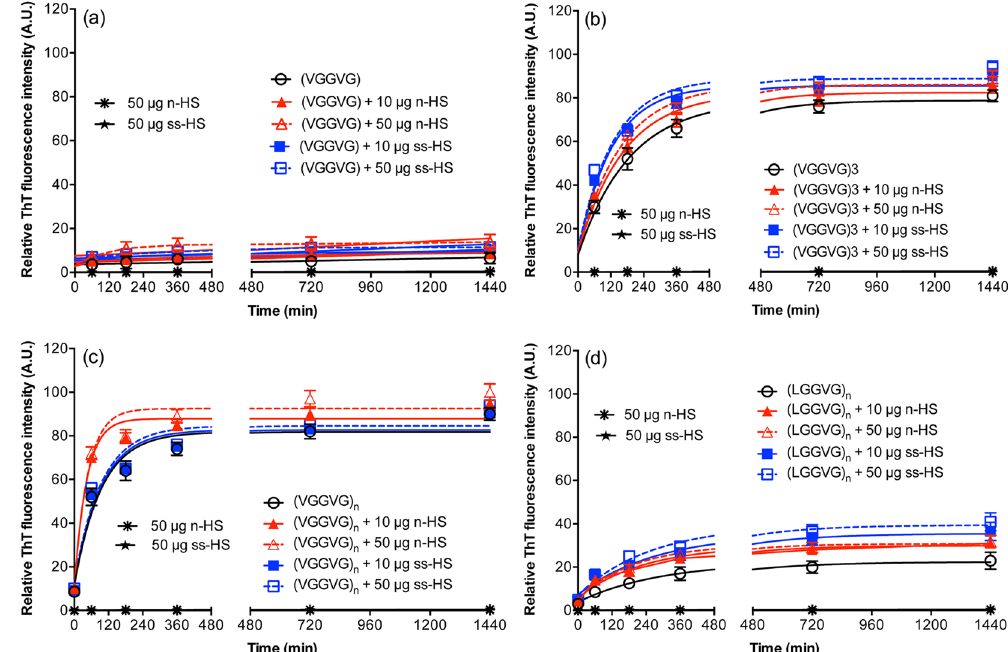
Figure 1. Thioflavin T (ThT) fluorescence for real-time monitoring of fibrillation kinetics. ( a ) (VGGVG), ( b ) (VGGVG) 3 , ( c ) (VGGVG) n and ( d ) (LGGVG) n were incubated in aqueous solution for 24 h at 37 °C in the absence or in the presence of natural (n-HS) or of semisynthetic (ss-HS) heparan sulfates. In each panel, data of ThT assay for n-HS and ss-HS alone (50 μ g/mL) are also shown. Data are expressed as the mean ± SD of three